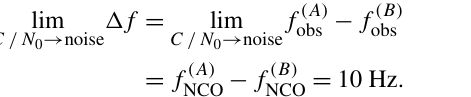
imuth angles less than 270 ◦ (west to south-west) the refrac- tivity profile is extracted from ECMWF grid point (52 ◦ N, 12 ◦ E), about 84.4 km south-west of the observation site (240 . 2 ◦ true bearing). For azimuth angles greater than 270 ◦ (west to north-west) the ECMWF grid point (53 ◦ N, 12 ◦ E) is